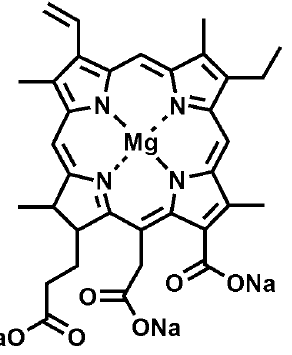
Figure 2. Molecular structure of Sodium Magnesium Chlorophyllin in photosensitizer formulation, SUN-D-06 PS.